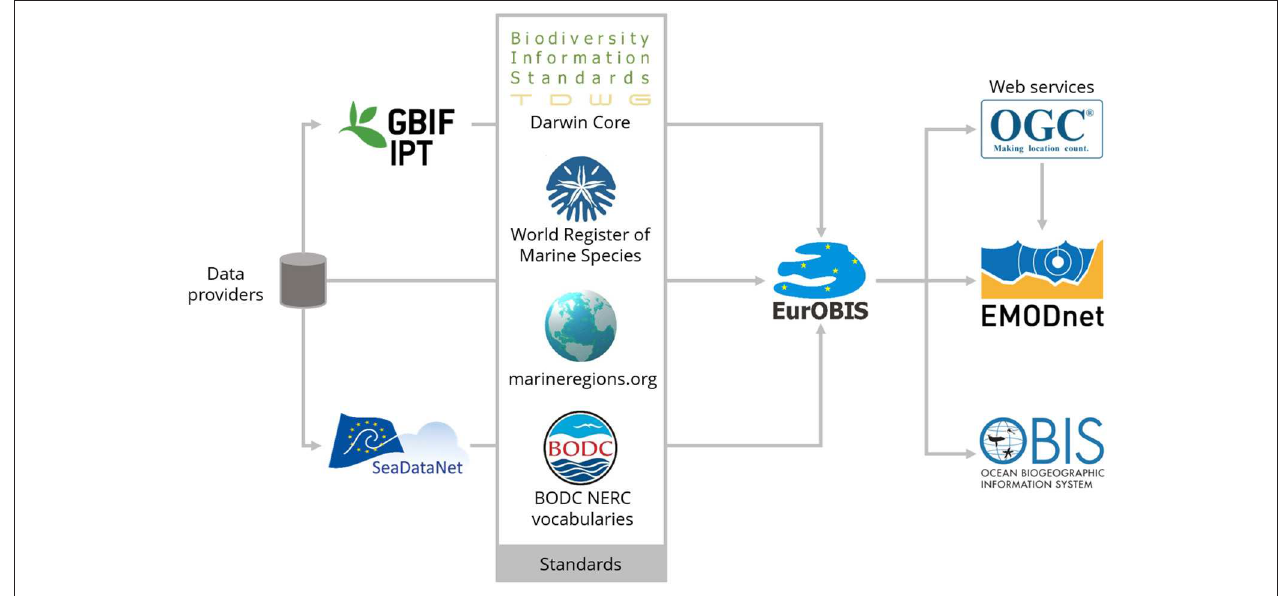
FIGURE 5 | Representation of data flow used within EMODnet